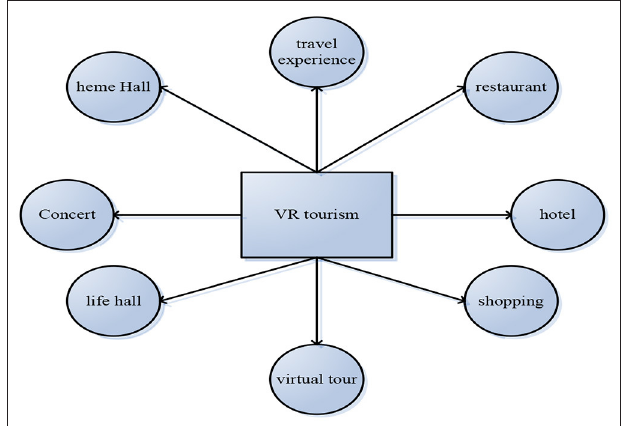
FIGURE 3 | Virtual tourism emotional VR model.